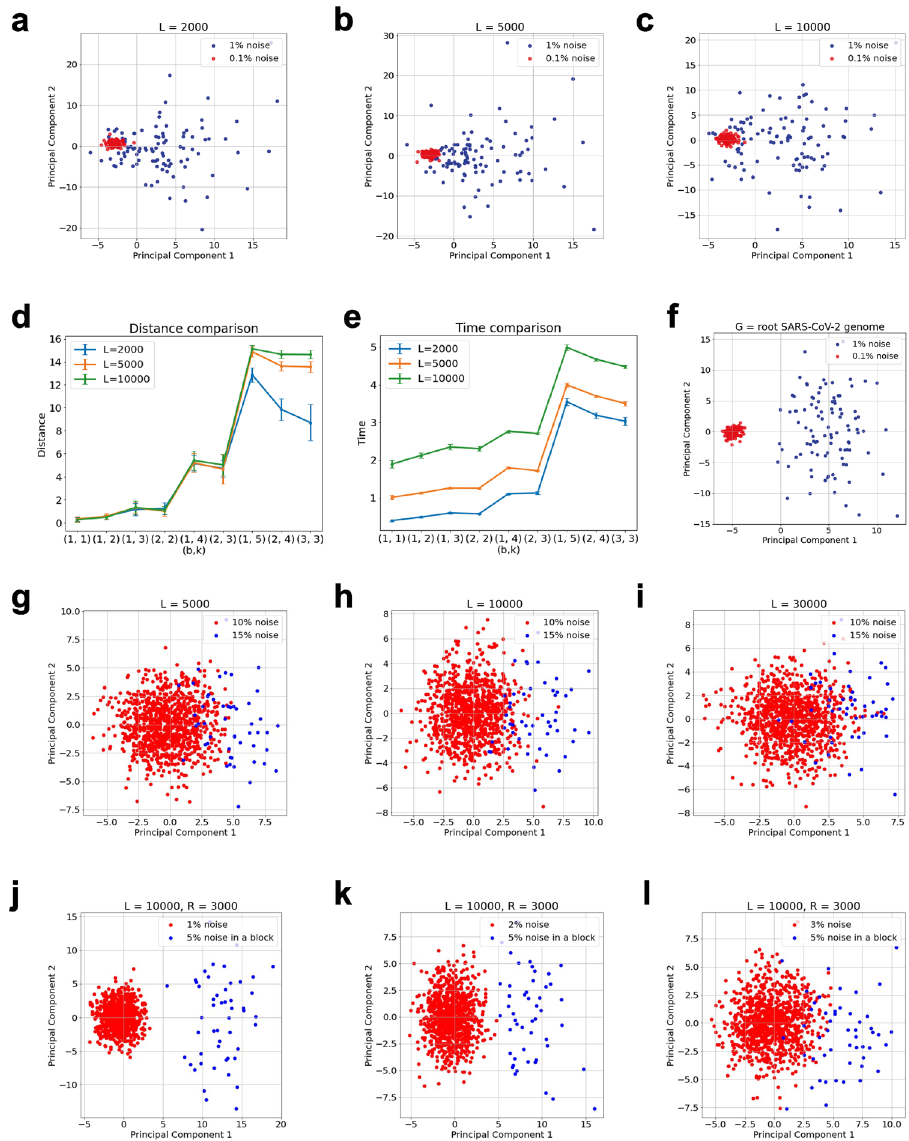
Figure 2. Clustering of Sequences. (a–e) Red and blue sequences are generated by adding substitution, insertion and deletion noise with probability 0.1% and 1% respectively. ( a – c ) show the first 2 principal components as a result of applying PCA on the state machine representations of the sequences with k = 4, b = 1, β = 0.5. for L = 2000, 5000, 10000 respectively. ( d ) shows distances between the centers of the red and blue clusters generated by different combinations of b and k , while ( e ) shows the time complexity of the method with different combinations of b and k , we repeat 20 times in each experiment and show the mean and standard deviation. (f) Red and blue sequences are generated by adding substitution, insertion and deletion noise with probability 0.1% and 1% respectively on the root SARS-CoV-2 sequence. ( f ) illustrates similar clustering performance for k = 4, b = 1, β = 0.5 as observed in ( a – c ) when noise is applied on a real sequence, i.e. SARS-CoV-2. ( g–i ) Red and blue sequences are generated by adding substitution, insertion and deletion noise with probability 10% and 15% respectively. ( g – i ) show the first 2 principal components as a result of applying PCA on the state machine representations of the sequences with k = 4, b = 1, β = 0.5. for L = 5000, 10000, 30000 respectively. ( j–l ) The red sequences have a noise level of x % and are of length L = 10000. The blue sequences of length L = 10000 have a noise level of x % in locations 1 − 1000 and 4001 − 10000 , and a noise level of 5% in locations 1001 − 4000 . ( j – l ) show the first two principal components of applying PCA on the state machine representation (with k = 4, b = 1, β = 0.5 ) of red and blue sequences for x = 1, 2, 3